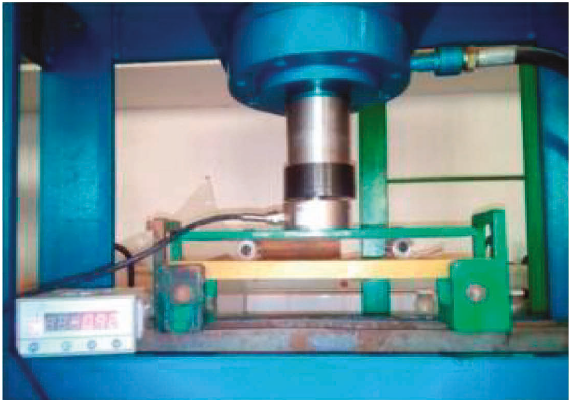
Figure 6: Four point bending test device.